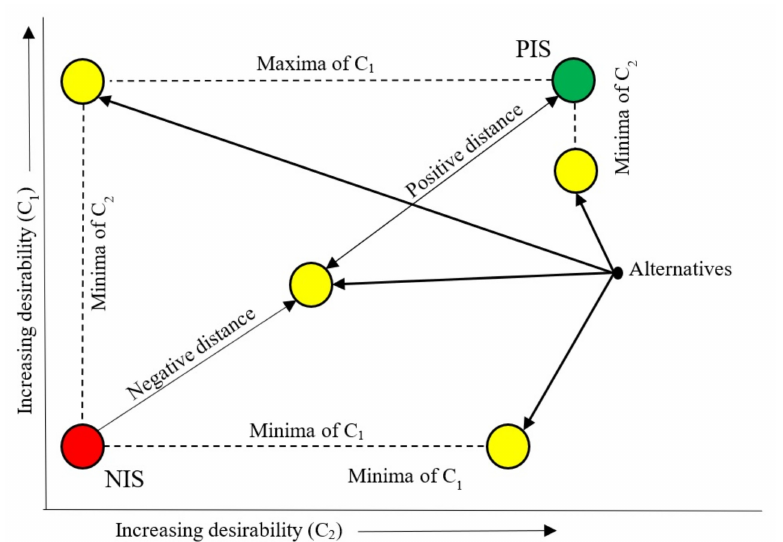
Figure 1. Graphical presentation of the TOPSIS technique based on Tramarico et al.